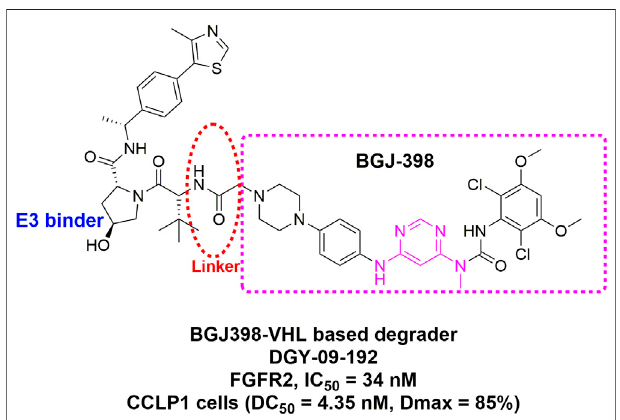
FIGURE 15 | Chemical structure of potent FGFR 1/2 degrader DGY- 09 –